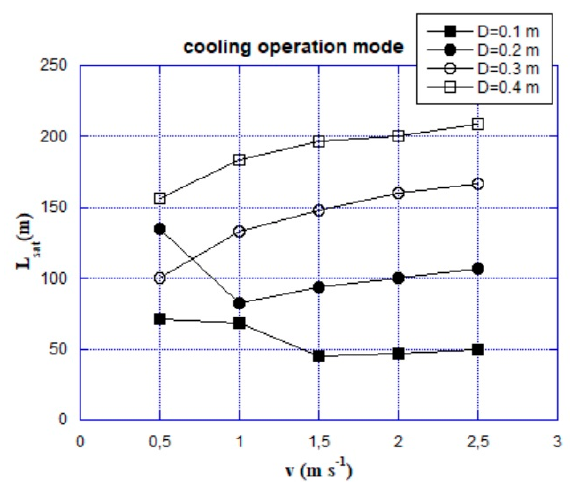
Figure 6. Saturation lengths vs. inlet air velocity parametrized for the diameter while the EAHX works in cooling mode.